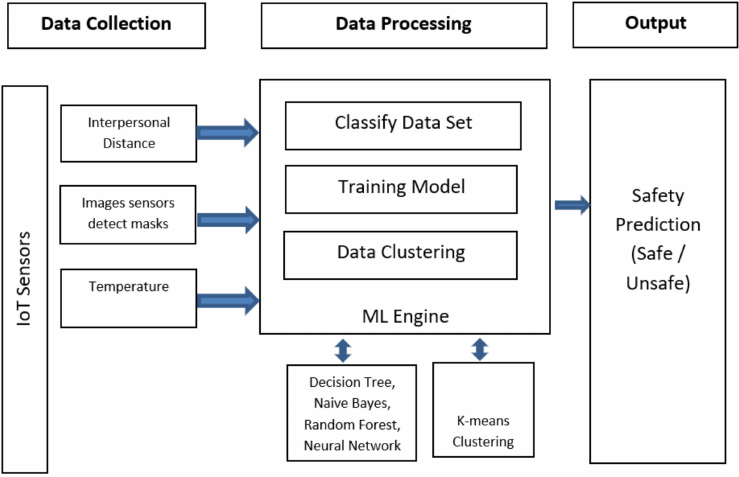
Figure 2. Architecture of the